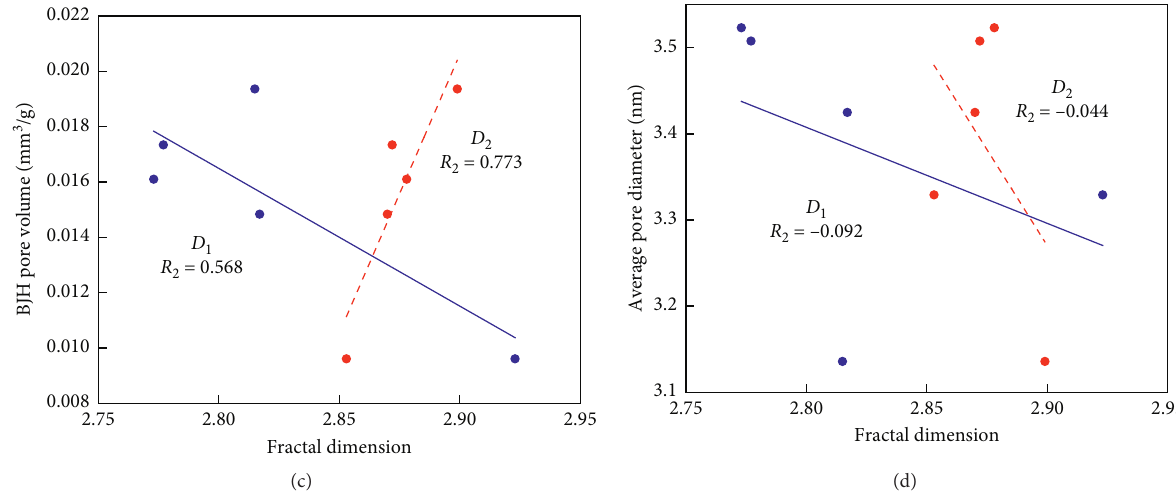
1 and D 2 ) and (a) porosity, (b) BETspecific surface area, (c) BJH pore volume, and